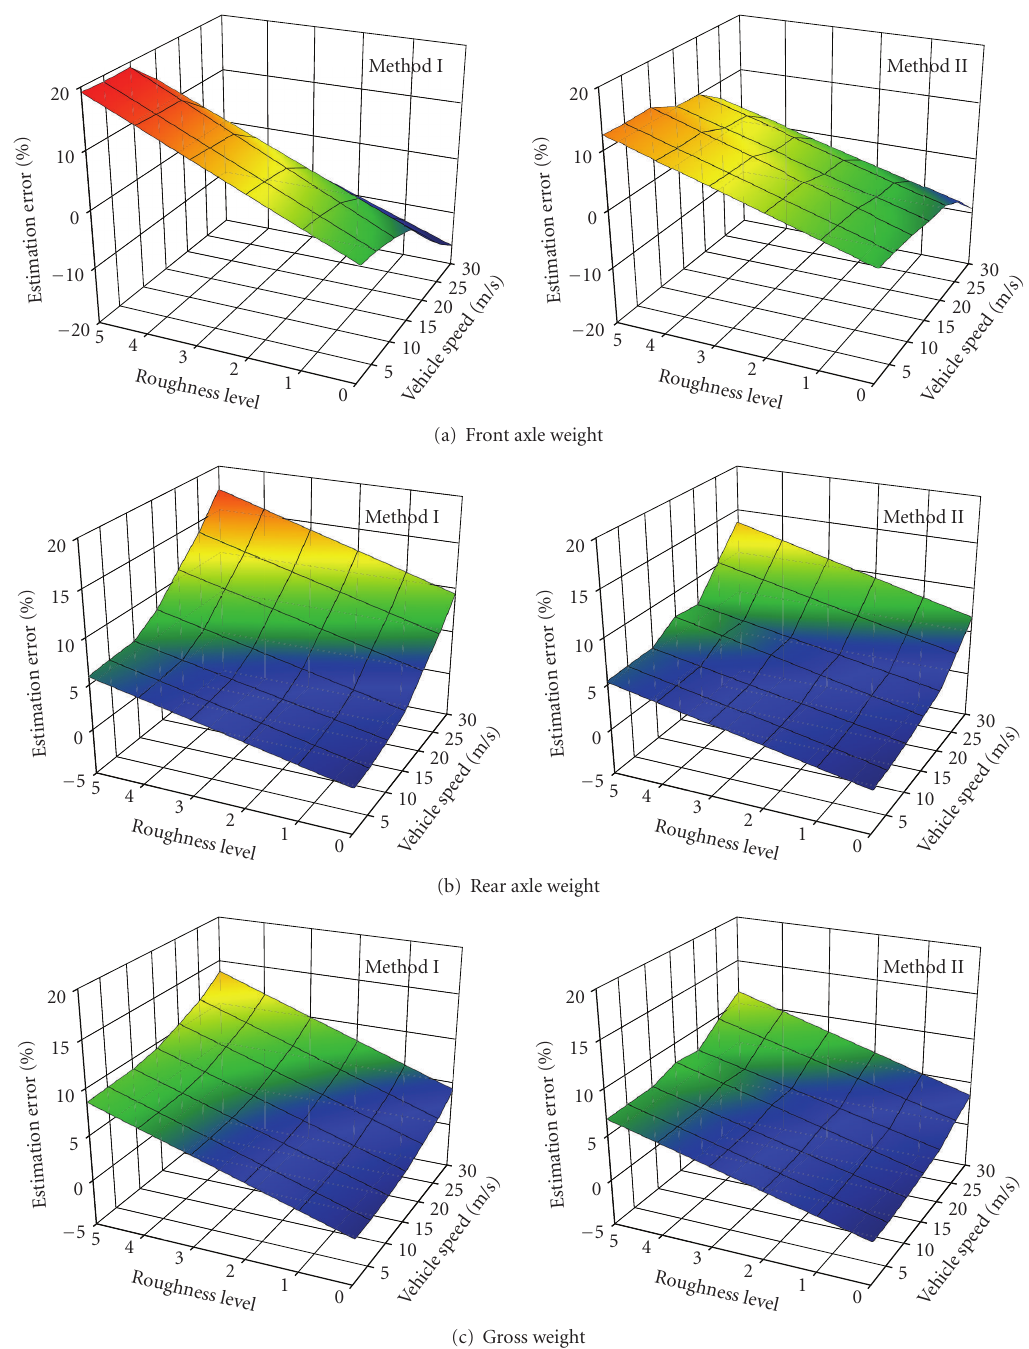
Figure 6: Estimation errors of axle weights under various roughness levels and vehicle speeds for (a) front axle weight, (b) rear axle weight, and (c) gross